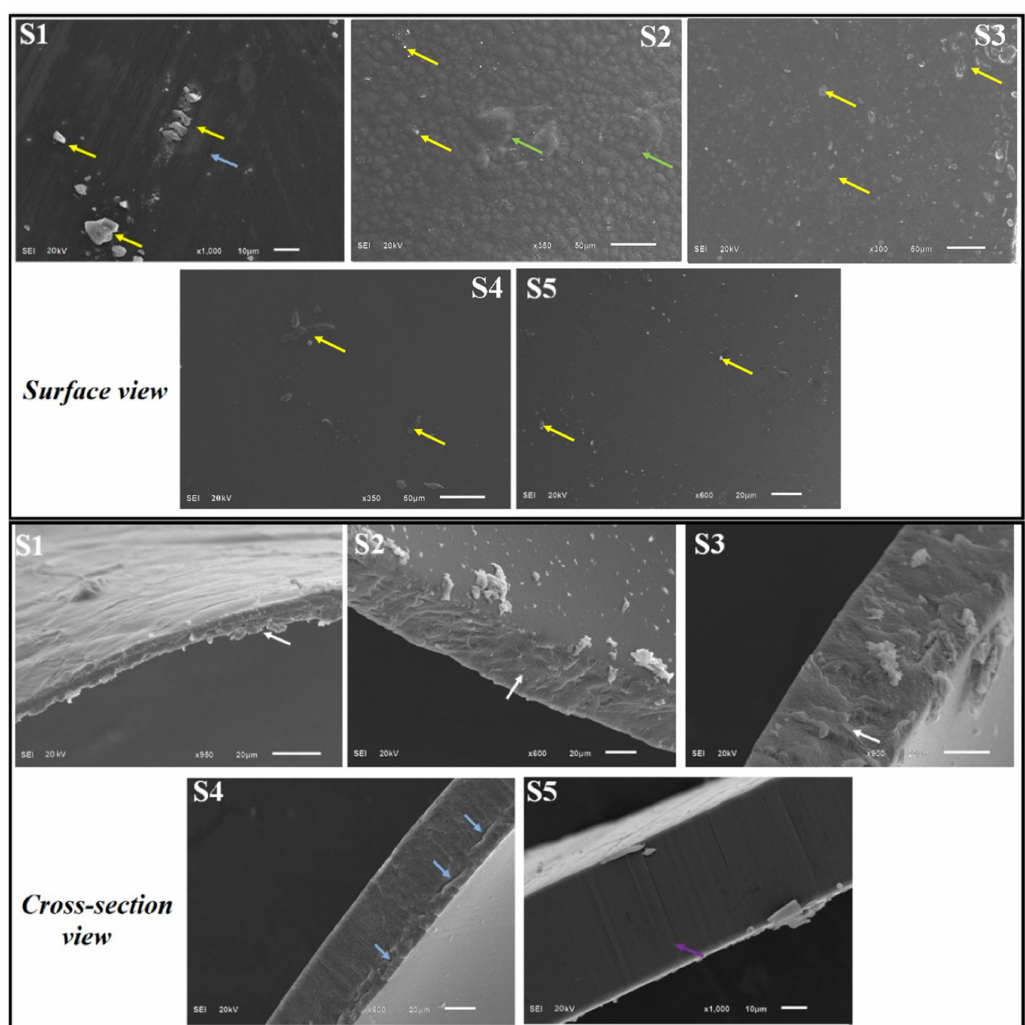
Figure 5. SEM images of CS blank film (S1), CS-Gly film (S2), CS-Gly-GEO film (S3), CS-POR-Gly film (S4), and CS-POR-Gly-GEO film (S5) (superior and cross section view); yellow arrows represent particles over the surface; purple colour arrows indicate compact, uniform, homogenous, and dense structure; green colour represents bulges over the surface and roughness; white arrows represent porosity and irregularity in the film; and blue arrows represents the cracks over the surface and